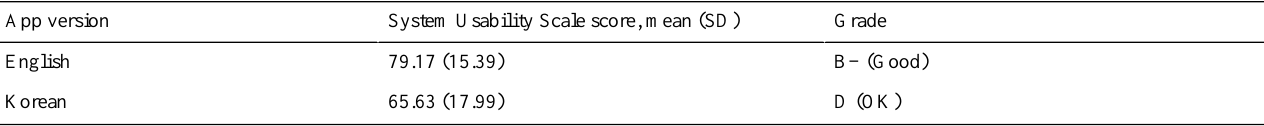
Table 1. Speech Banana usability scores. Letter grades are derived from a normalized scale.